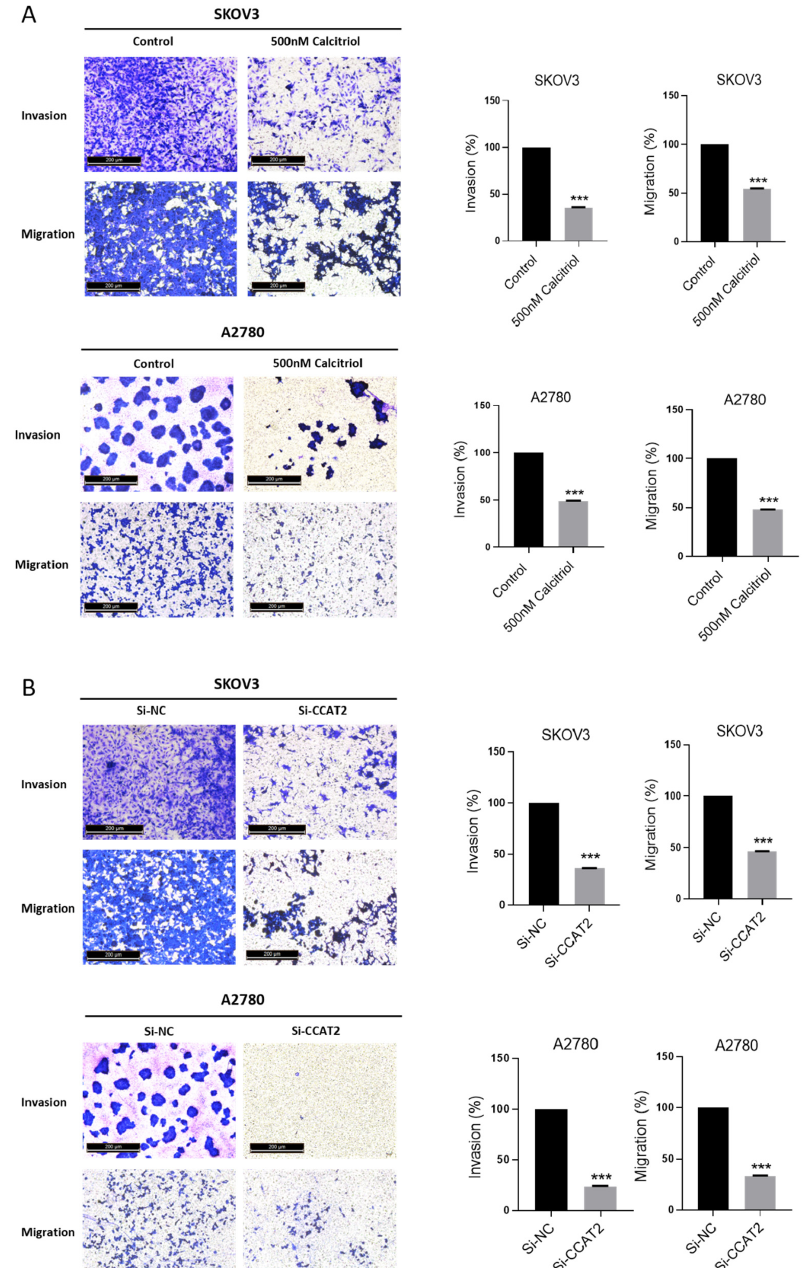
Figure 5. Calcitriol suppressed the migration and invasion of ovarian cancer cells. ( A ) SKOV3 and A2780 cells were treated with vehicle (0.1% DMSO) and 500nM calcitriol. ( B ) SKOV3 and A2780 cells were transfected with siRNA targeting CCAT2. The migration and invasion capacities were assessed using transwell assay. After resolving crystal violet into 33% glacial acetic acid, the invaded cell numbers of each well were quantified by absorbance values at 590 nm. (***) p < 0.001.